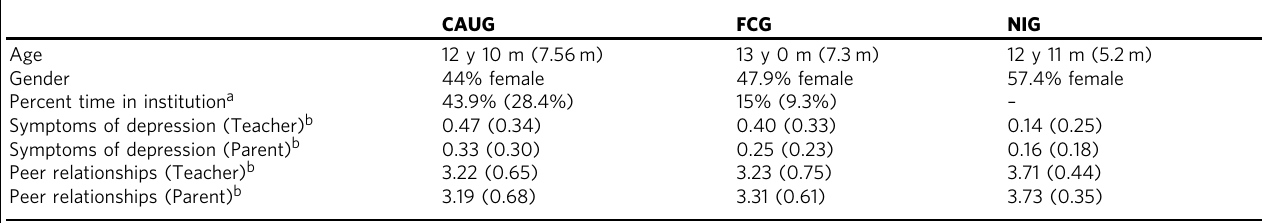
Table 1 We present data on age, gender, percent of life spent in an institution by participation in the age 12 follow-up